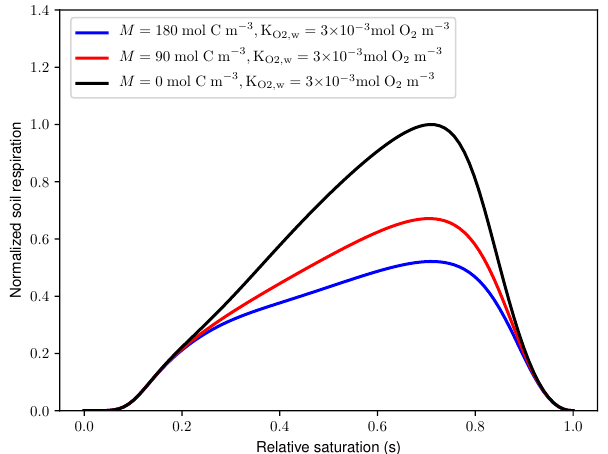
Figure 6. Simulated moisture response functions using elevated affinity parameter for O 2 . The respiration data are normalized with the peak value from the case with zero soil minerals (i.e., black line in the